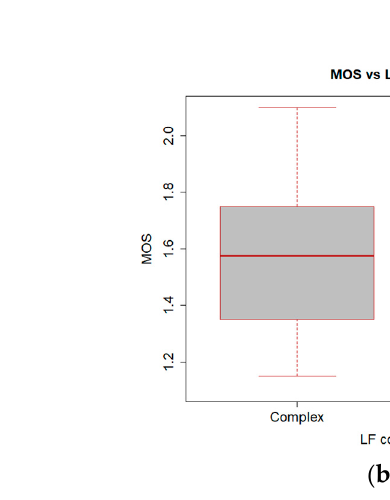
Figure 6. The variation of MOS scores and LF content with different distortion levels: ( a ) good quality case (QP22), ( b ) poor quality case (QP50).